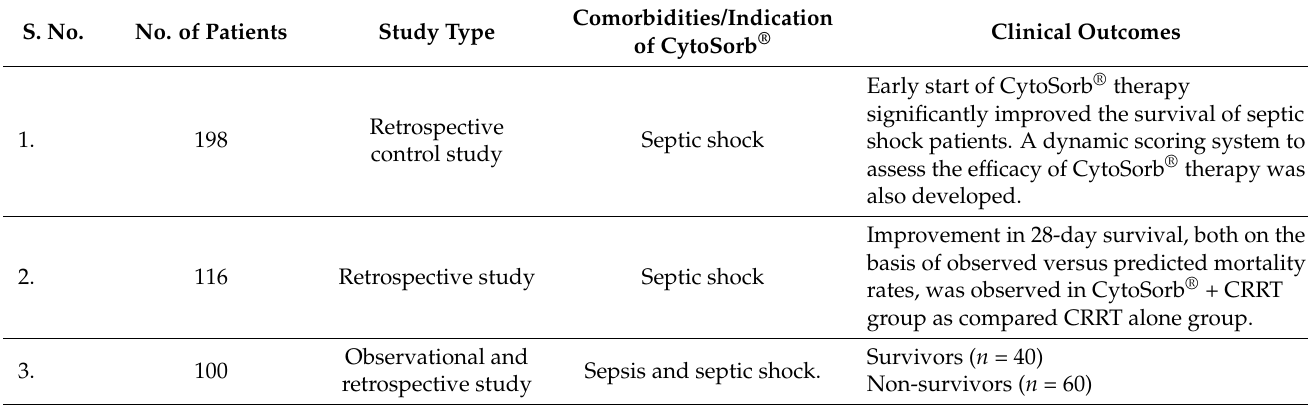
Table 2. Peer-reviewed studies showing the effectiveness of CytoSorb ®